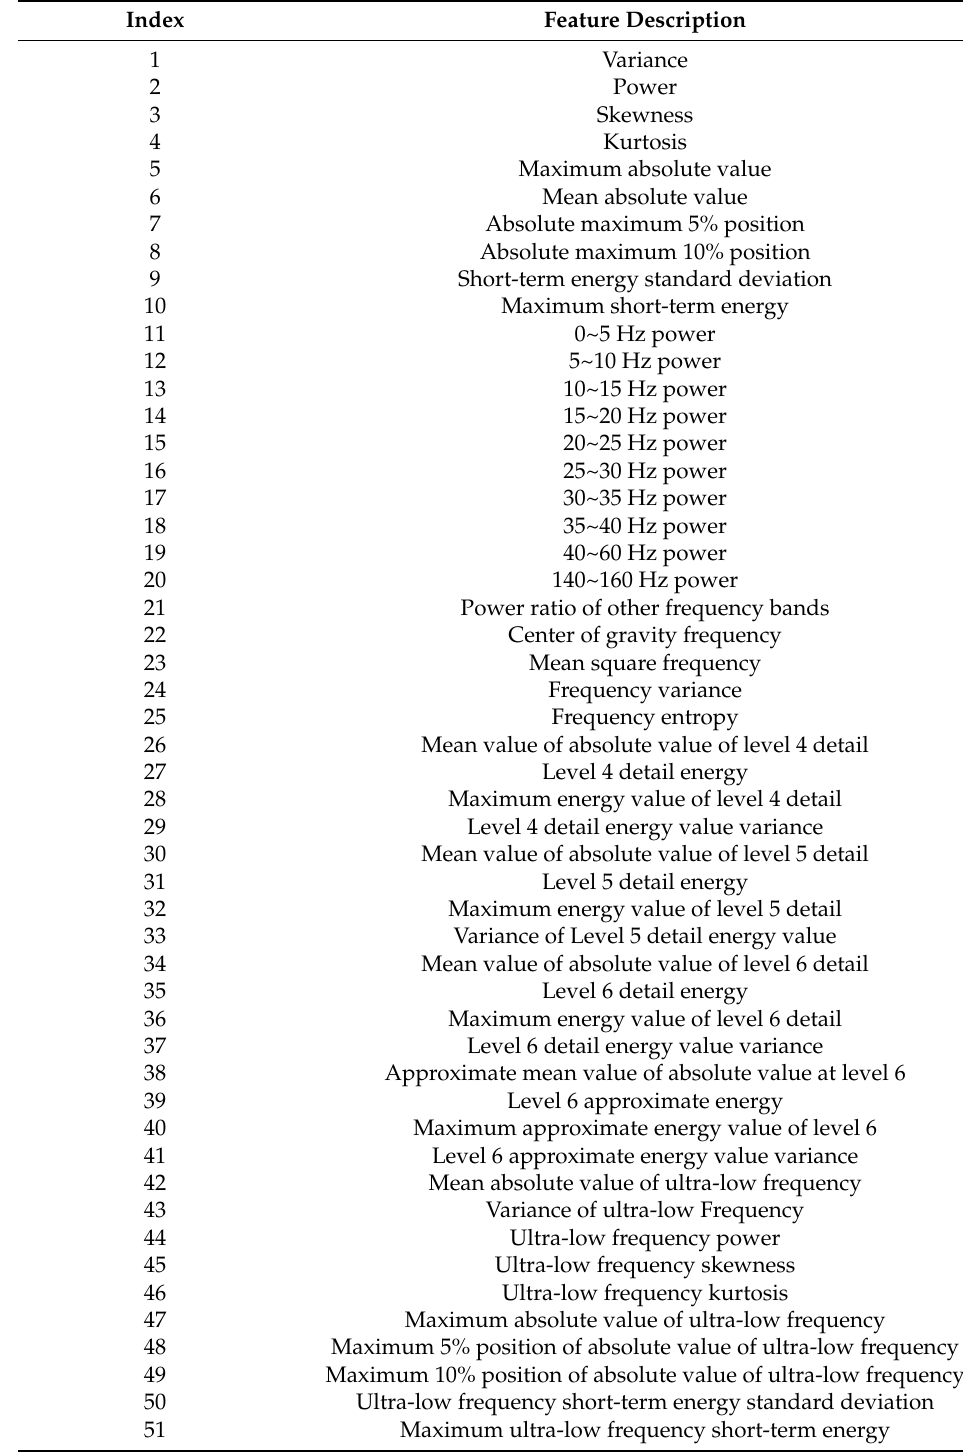
Table 1. The extracted shallow 51